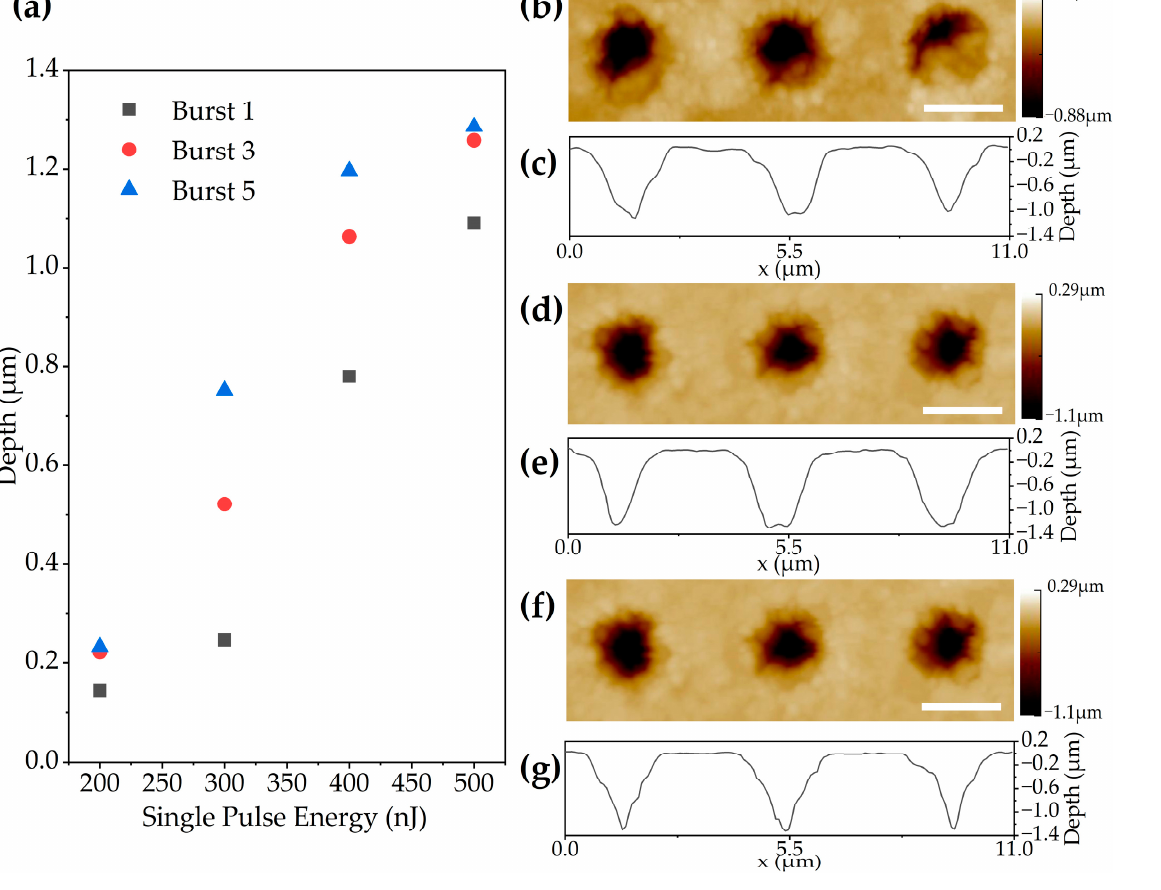
Figure 4. ( a ) The average depth of the ARMs’ craters in different single-pulse energy and burst mode. The AFM image of ARMs’ craters with 500 nJ of single-pulse energy and ( b ) burst 1, ( d ) burst 3, and ( f ) burst 5 modes. The profiles along the center of the ARMs’ craters with 500 nJ of single-pulse energy and ( c ) burst 1, ( e ) burst 3, and ( g ) burst 5 modes. The white scale bar represents 2.5 µm. Then, the transmission of the bulk ZnSe sample and ARMs of 0.1 × 0.1 mm 2 with various parameters was measured by using an FTIR spectrometer in the range of 5–15 µ